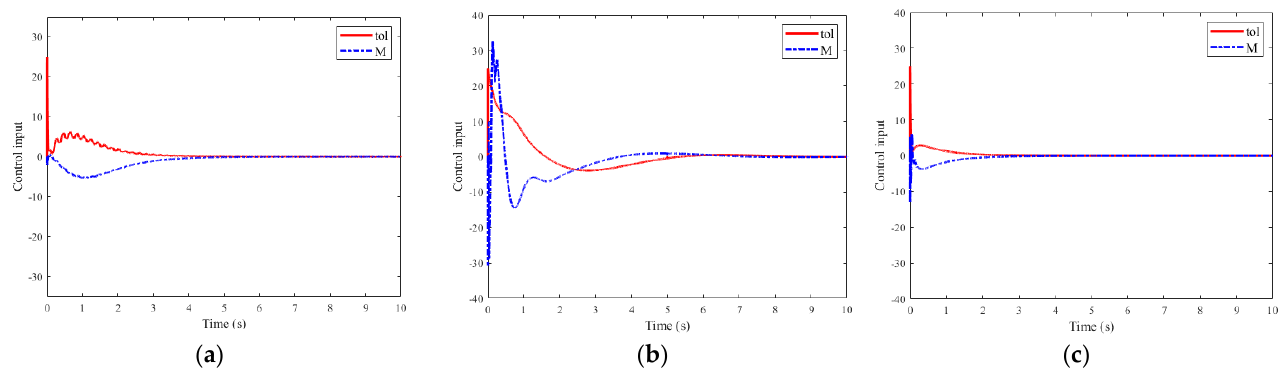
( c ) Figure 5. The deformation results of different methods: ( a ) adaptive boundary method; ( b ) RBF neural network method; ( c ) the proposed method. ( a ) ( c ) Figure 6. The deformation rate results of different methods: ( a ) adaptive boundary method; ( b ) RBF neural network method; ( c ) the proposed method.